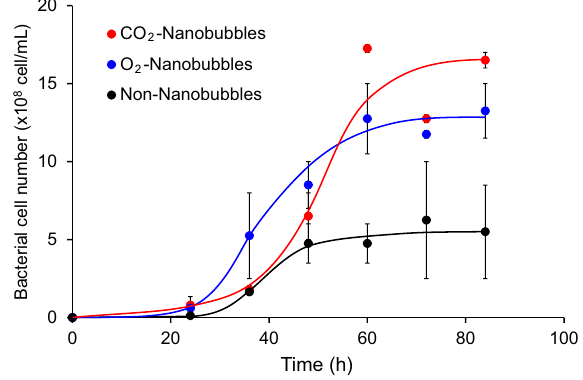
Figure 2. Growth curve of P . aeruginosa cultured in Cooper’s medium. Bacterial cell number of P . aeruginosa cultured in the carbon dioxide nanobubbles medium (red closed circles), oxygen nanobubbles medium (blue closed circle) and nanobubbles-free medium (black closed circle).